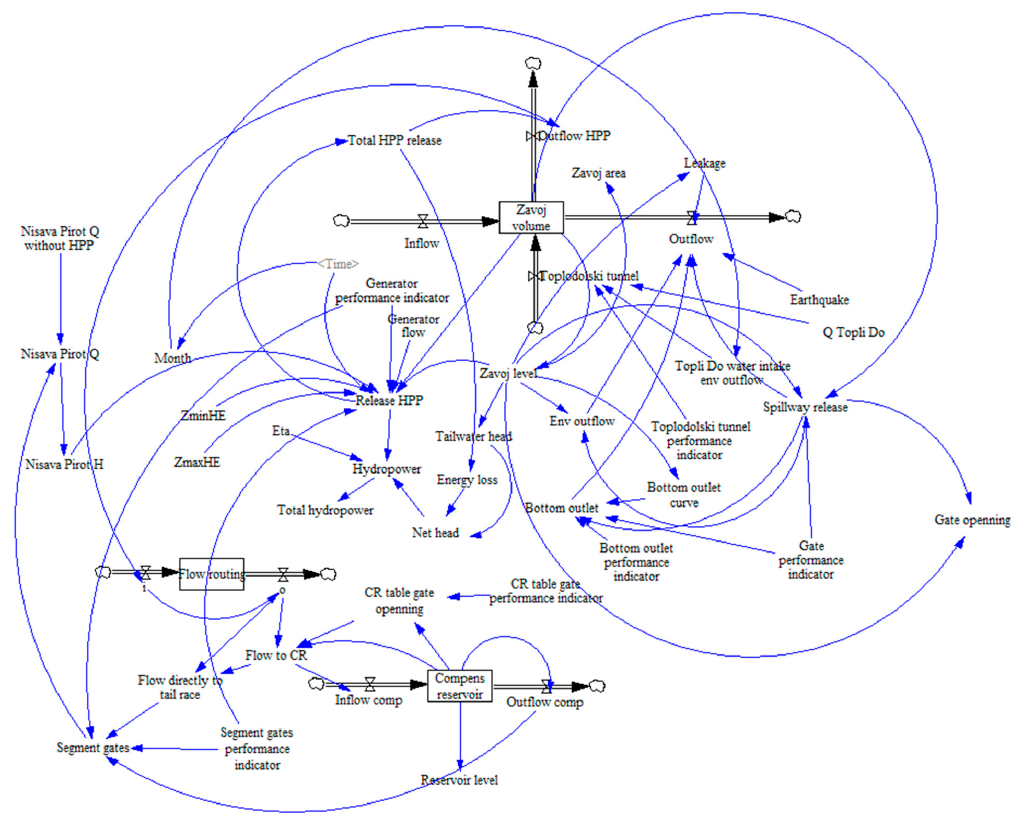
Figure 5. System dynamics simulation model of the Pirot reservoir System.